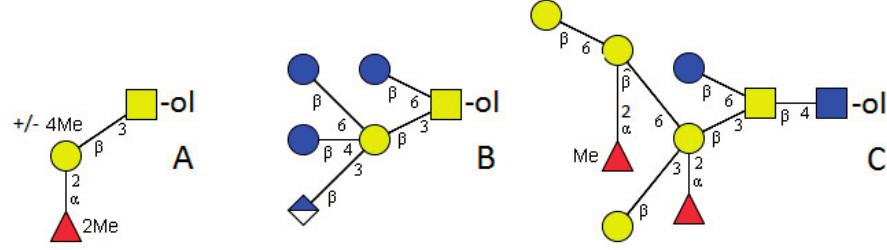
Figure 2. Examples of extended O- glycans in nematodes. ( A ) Toxocara [22]; ( B , C